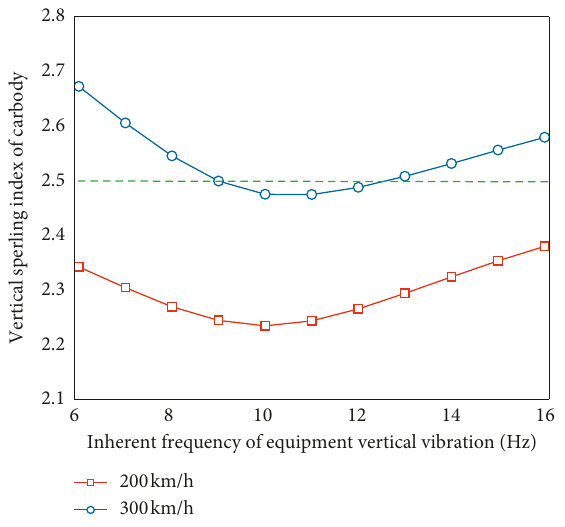
Figure 5: Vertical Sperling index of the car